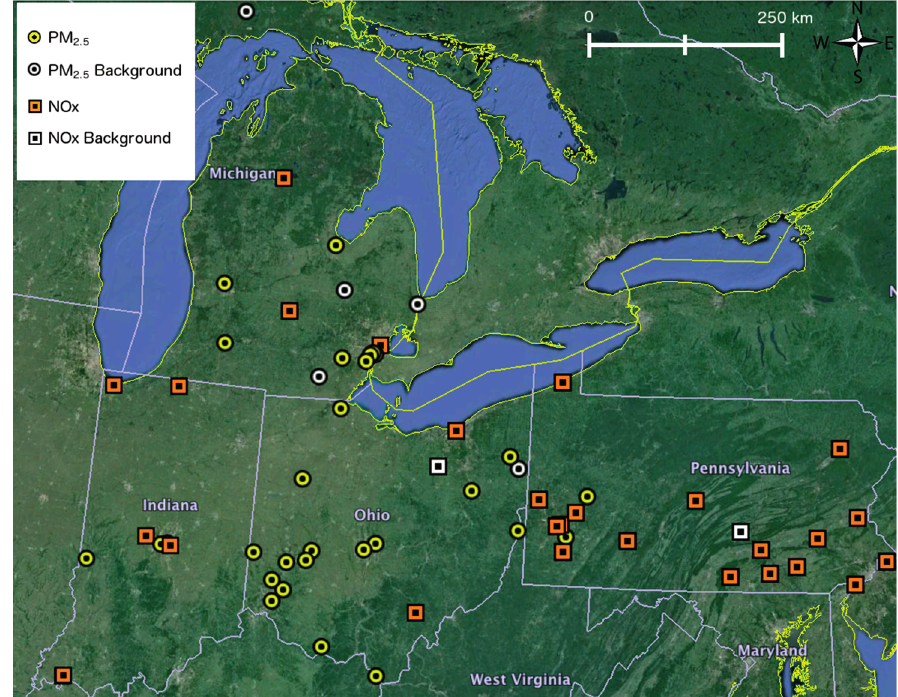
Figure 2. Location of AQS monitors used in the STOK algorithm.